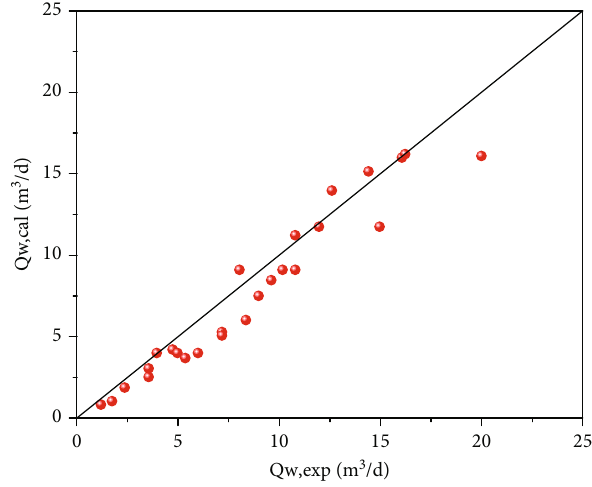
Figure 11: Comparison diagram of experimental and calculated water phase fl ow.